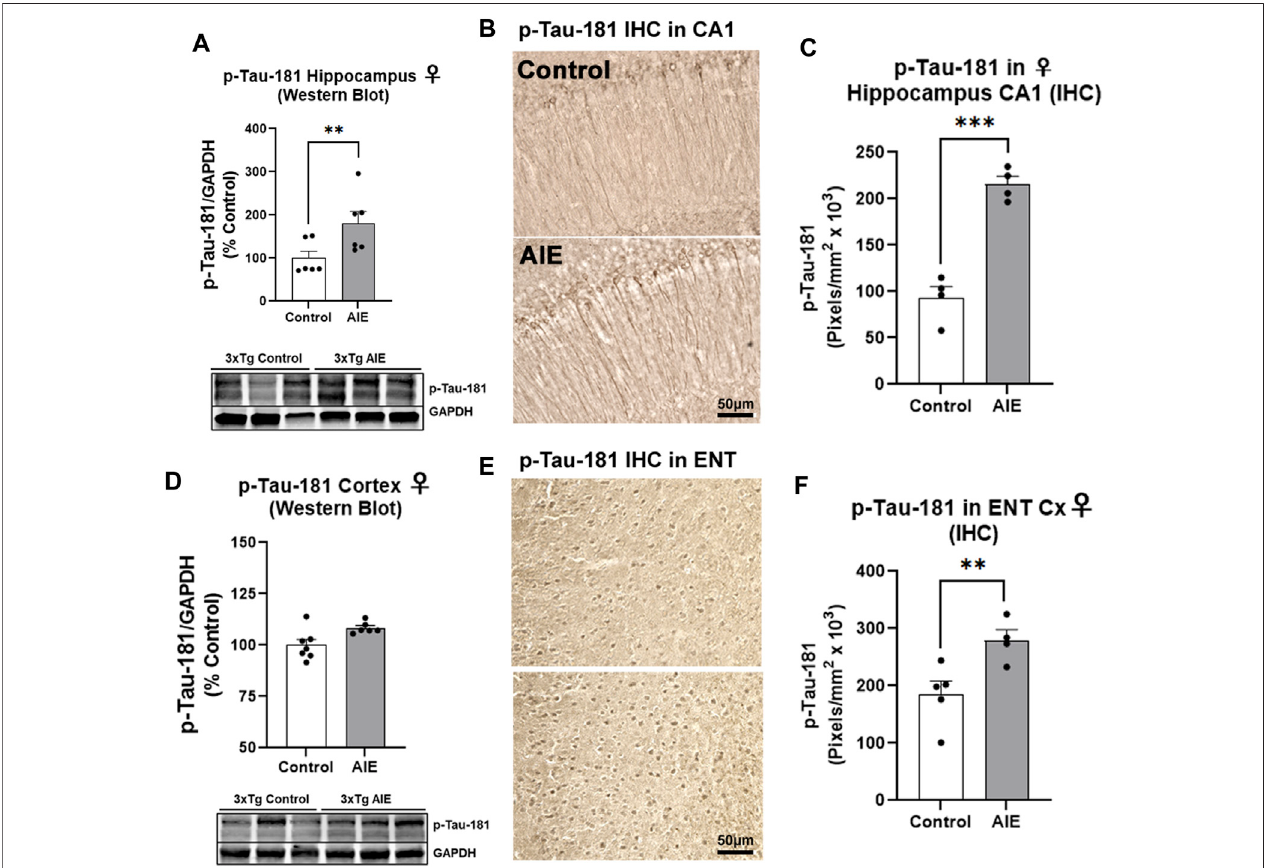
FIGURE3 | AIE enhances tau pathology in adult female 3xTg-ADmice.3xTg-AD mice received either AIE (5 g/kg/day, i.g., 2-days on 2-days off, P25-55) or water gavage and were assessed for tau pathology at P200. (A) Western blot of adult hippocampus found an 80% increase in phosphorylated tau at Thr181 (p-tau-181) after AIE. ** p < 0.01, Sidak ’ smultiple comparisons test. N =6 control, 6ethanol (B) Representative high magni fi cation image of p-tau-181 stainingin CA1 of control and AIE- treated subjects at P200. (C) Quanti fi cation of p-tau-181 staining in female CA1 found a 2-fold, increase after AIE. **p < 0.01, t - test N = 4 control, 4 ethanol (D) Westernblotofadultwholecortexshowednosigni fi cantchangeinp-Tau-181( p =0.21,Sidak ’ smultiplecomparisonstest). N =7control,6ethanol. (E) Representative highmagni fi cationimageofp-tau-181staininginENTCxregionofcontrolandAIE-treatedsubjectsatP200. (F) Quanti fi cationofp-tau-181stainingintheENTCxfound a 51%, ( **p < 0.01, Sidak ’ s post-test N = 5 control, 4 ethanol) increase by AIE. * p < 0.05, ** p <